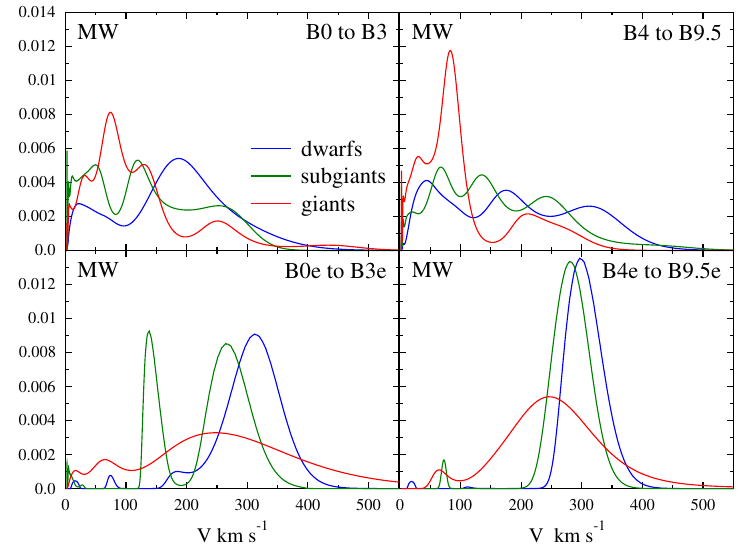
Figure 30. Normalized distributions of true rotational velocities of Milky Way (MW) B and Be stars separated by spectral type groups and luminosity classes. Velocities are not corrected for the gravitational darkening effect. Adapted from Zorec